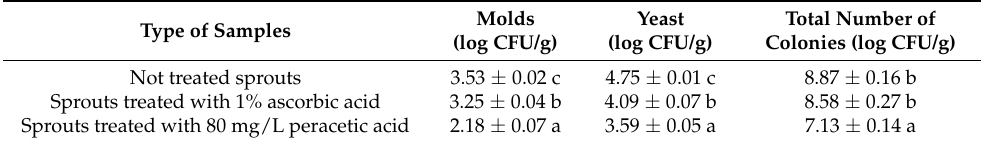
Table 10. Microbiological quality of red cabbage sprouts treated with aqueous solutions of ascorbic and peracetic acids after 14-day storage ( n =